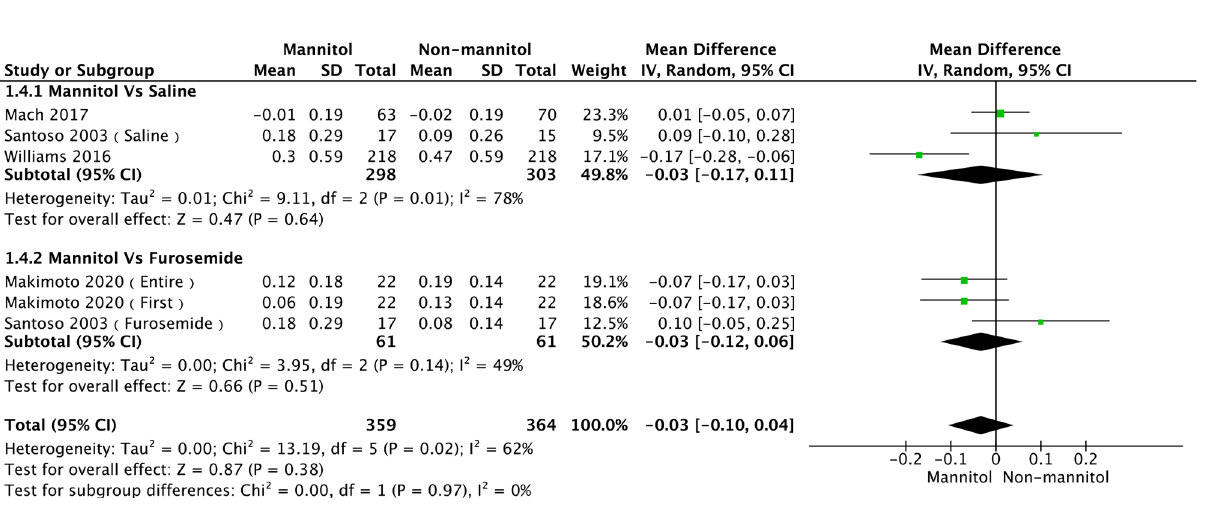
FIGURE 7 | Forest plot of mean difference (MD) for Serum Creatinine (Scr).